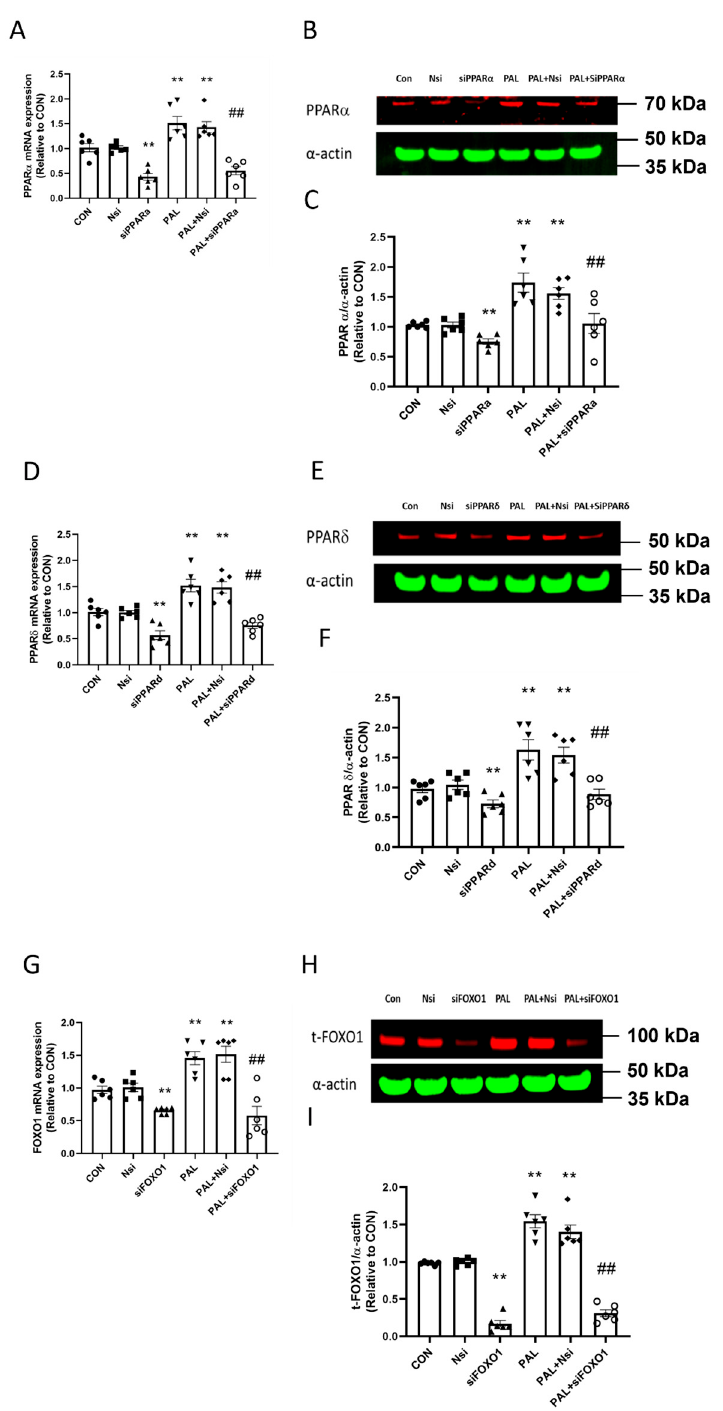
Figure 1. Validation of individual PPAR α , PPAR δ and FOXO1 siRNA gene silencing at transcriptional ( A , D , G , respectively) and translational levels ( B , C , E , F , H , I , respectively) in C2C12 myotubes in the absence ( left panels ) or the presence of palmitate (PAL; right panels ). Significantly different from control without PAL (CON, ** p < 0.01). Significantly different from CON + PAL ( ## p < 0.01). Data represent mean ± SEM of 6 individual experiments for each intervention group. Nsi—silencer negative control. Full WB can be found in Supplementary